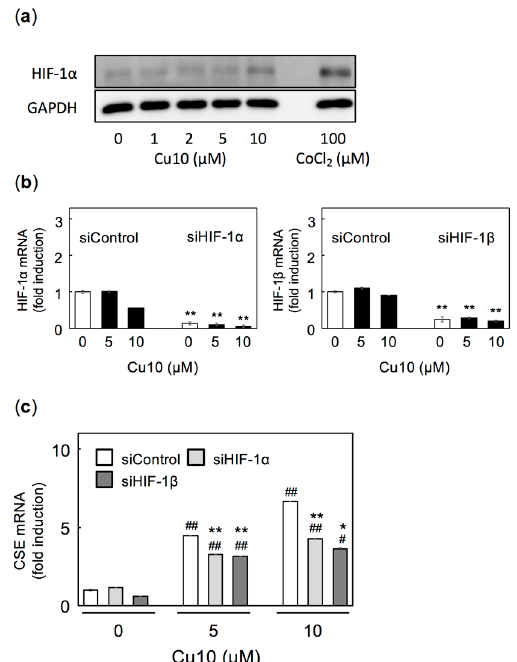
Figure 4. Possible involvement of hypoxia signaling in induction of CSE transcription by Cu10. ( a ) hypoxia-inducible factor (HIF)-1 α activation by Cu10. Dense cultures of bovine aortic endothelial cells were treated with Cu10 (1, 2, 5, and 10 µM) or CoCl 2 (100 µM) for 3 h. CoCl 2 was used as a positive control. The results of the densitometric analysis are shown in Figure S3. ( b ) HIF-1 α and HIF-1 β mRNAs in vascular endothelial cells after siRNA-mediated knockdown of HIF-1 α and HIF-1 β , respectively. Subconfluent cultures of bovine aortic endothelial cells transfected with either the control, HIF-1 α , or HIF-1 β siRNA for 12 h and treated with Cu10 (5 and 10 µM) for 12 h. Values are mean ± SE of three technical replicates. ** Significant difference from the corresponding siControl, p < 0.01. ( c ) Possible involvement of HIF-1 α and HIF-1 β in the induction of CSE transcription in vascular endothelial cells after Cu10 treatment. Subconfluent cultures of bovine aortic endothelial cells transfected with either the control, HIF-1 α , or HIF-1 β siRNA for 12 h and treated with Cu10 (5 and 10 µM) for 12 h. Values are mean ± SE of three technical replicates. Significant difference from the corresponding siControl, * p < 0.05; ** p < 0.01. Significant difference from the corresponding vehicle treated control (no Cu10), # p < 0.05; ## p < 0.01.